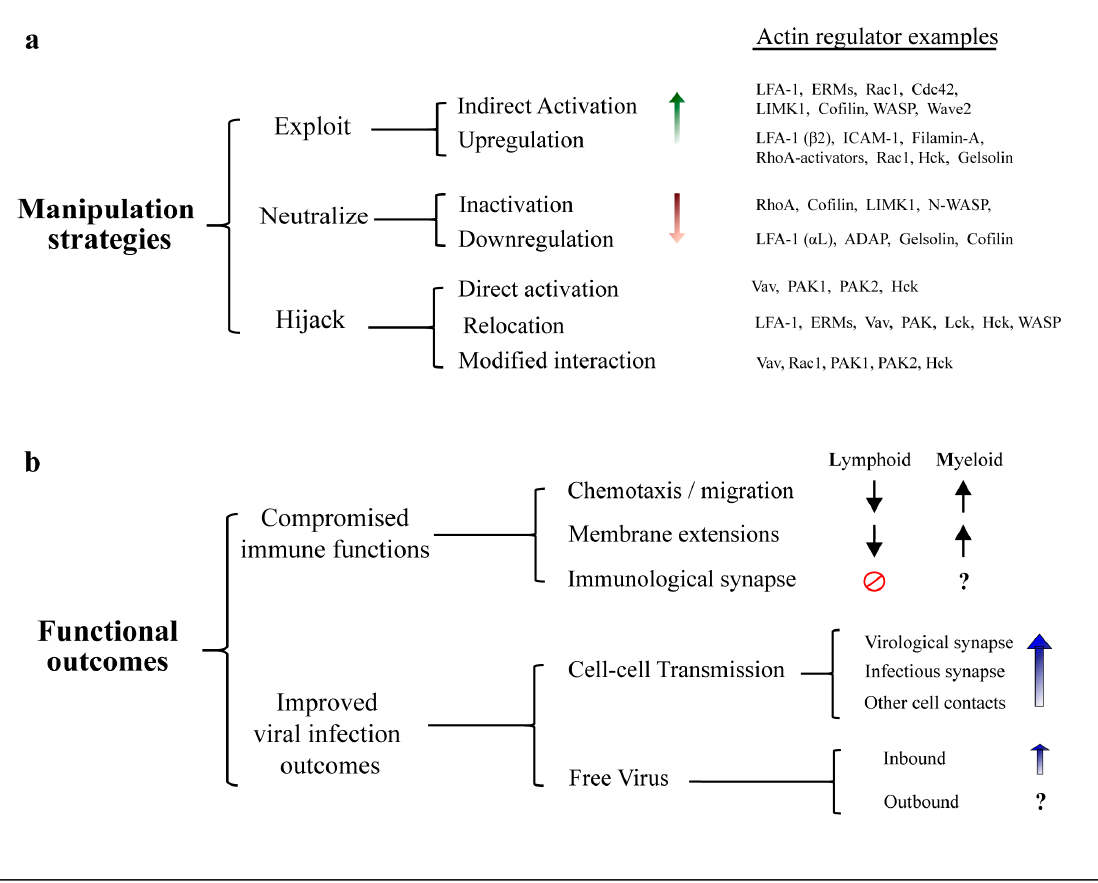
Figure 1. Manipulation of the actin cytoskeleton by human immunodeficiency virus (HIV). ( a ) Actin regulators subjected to modulation by HIV. Mechanistically diverse strategies enable the virus to alter cellular cytoskeletal functions. Manipulation of host factors can be either direct, when mediated by physical interaction with viral proteins, or indirect, when requiring upstream cellular factors. Exploitation mechanisms increase native protein activity by upregulation of gene expression, or indirect activation within a cellular pathway. Neutralization of host factors is achieved by downregulation of gene expression or protein inactivation. Hijacking alters the functional outcome of host protein activity, either by overriding regulatory mechanisms (i.e., direct protein activation), changing protein subcellular localization, and/or modifying protein interaction partners. Note that some host factors can be manipulated by multiple strategies at diverse stages of the viral life cycle, as well as differentially in infected and uninfected cells. Examples of actin regulators corresponding to each strategy are provided, however this is not a complete list; ( b ) Functional consequences of actin-dependent changes induced by HIV. Normal immunological functions are compromised upon HIV infection, partly due to actin-remodeling changes orchestrated by viral proteins. CD4+ lymphocytes display severe impairment of chemotaxis and immunological synapse formation. Myeloid cells display aberrant enhancement of actin dependent structures, which alters cell motility and tissue distribution. Concurrent changes in actin remodeling in both cell types also promote viral spread via actin-dependent cell-cell contacts and support infection by inbound cell-free virus. Subversion of the host actin cytoskeleton is essential for both establishing and spreading the infection by HIV. Virtually all known stages of the viral life cycle have been reported to be dependent on actin to lower or greater extent, including viral entry [6–8], reverse transcription [9], nuclear